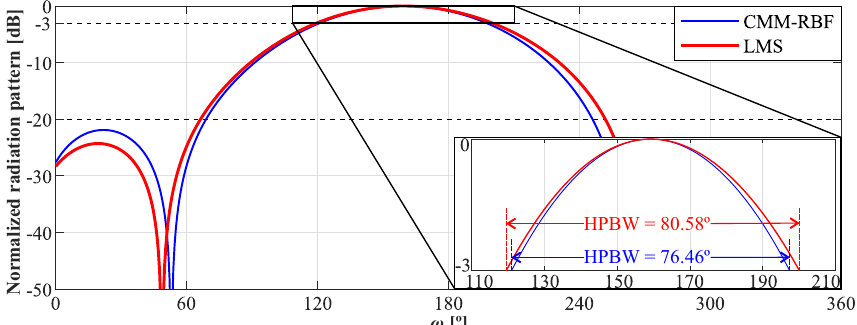
Figure 6. Normalized radiation pattern of the complex multiple-input multiple-output radial basis function neural network (CMM-RBF) and least mean square (LMS) algorithms for the uniform and circular array (UCA) with θ = 90 ◦ and ˆ ω = 160 ◦ .